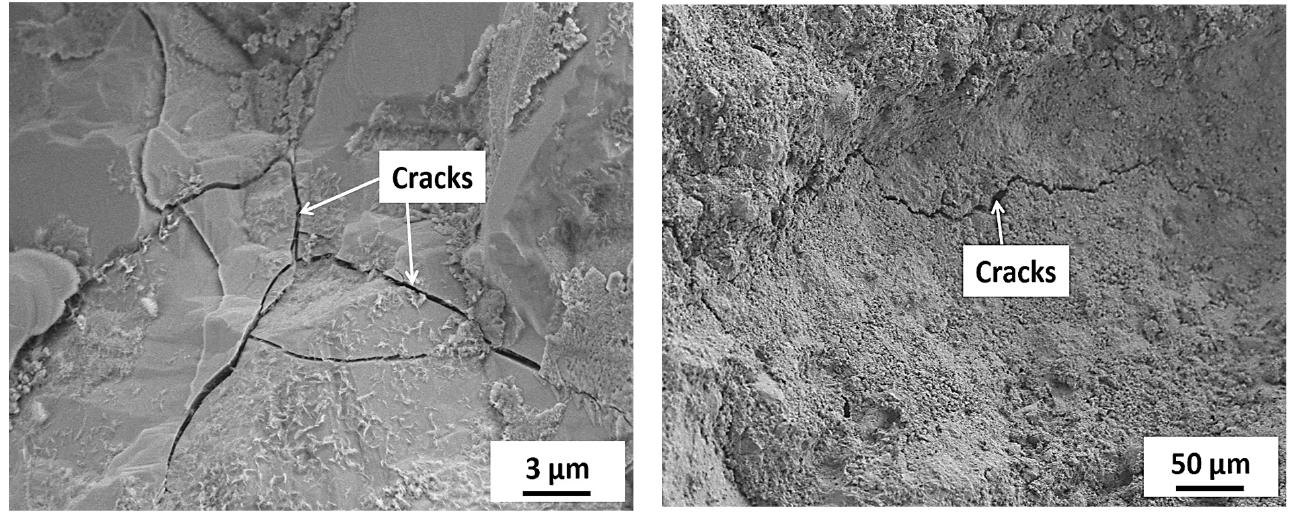
Figure 15. SEM images of specimens incorporating Orakzai source aggregates.